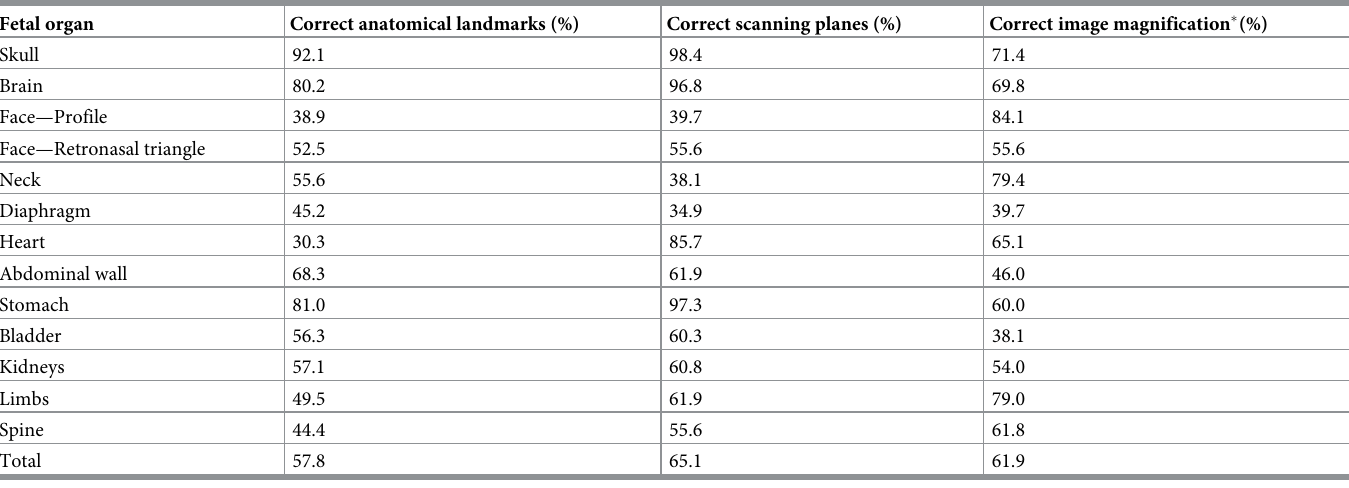
Table 7. Item scores for the evaluation of the ultrasound images per organ